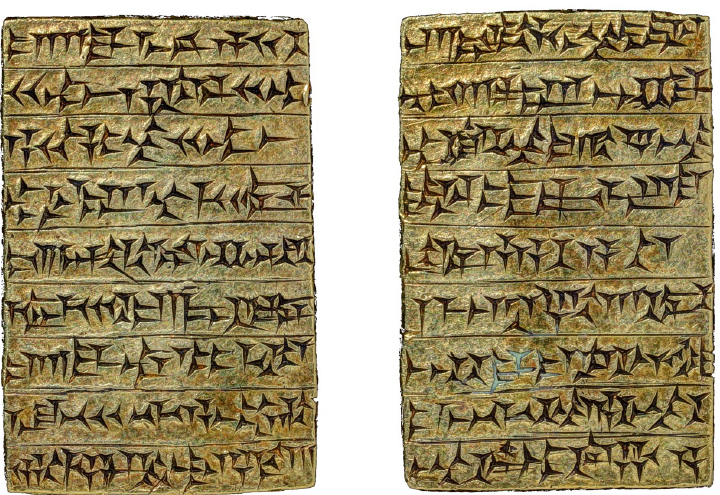
Fig 1. Example of cuneiform writing from a gold tablet of Ashurnas ˙irpal II. This is a foundation inscription buried under the palace of Ashurnas ˙irpal in the city Apqu (modern Tell Abu Marya, see link [3]), where it was found millennia later by archaeologists. After giving the titles of the king, the text introduces itself as a foundation inscription, written on gold and silver (the silver parallel of this copy was found alongside the gold). This is an anomaly for cuneiform texts, which were usually written on clay. Therefore, these inscriptions are a symbol of great wealth and extravagance. It ends with curse formulae for later princes who may dare to erase Ashurnas inscriptions. It is currently in the Yale Babylonian collection (YBC 2398; YPM BC 16991), republished from the Yale Peabody Museum of Natural History under a CC BY license, with permission from Klaus Wagensonner, original copyright